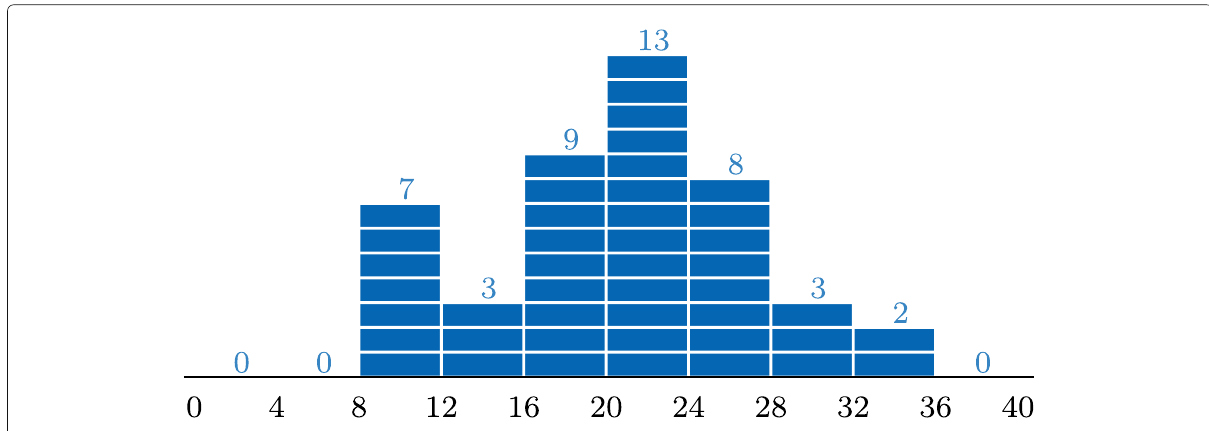
Fig. 1 Teacher’s assessment: 0 students were awarded n ∈ [0,8] marks, 7 students were awarded n ∈ ( 8,12],